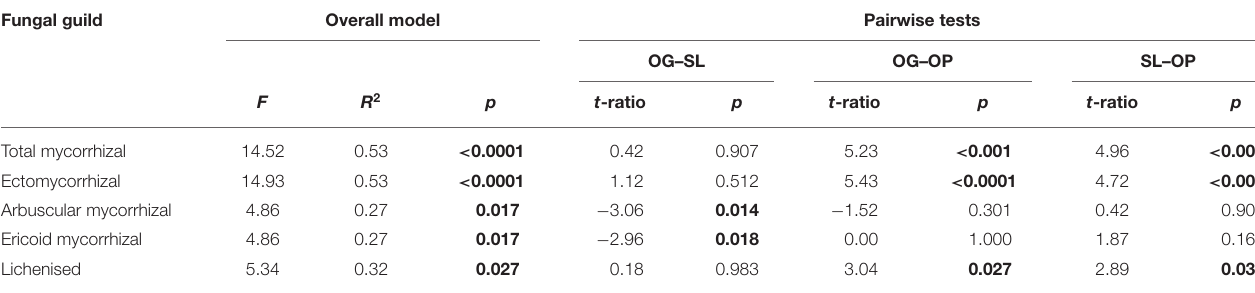
TABLE 4 | Linear mixed model (LMM) test statistics for significant differences in fungal guild relative abundances by land-use types of old-growth (OG) and selectively logged (SL) lowland dipterocarp rainforest and oil palm plantation (OP) in Sabah, Borneo. Fungal guild Overall